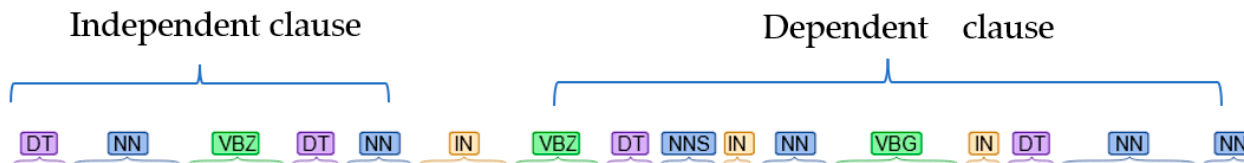
Figure 5. The example of a complex sentence.